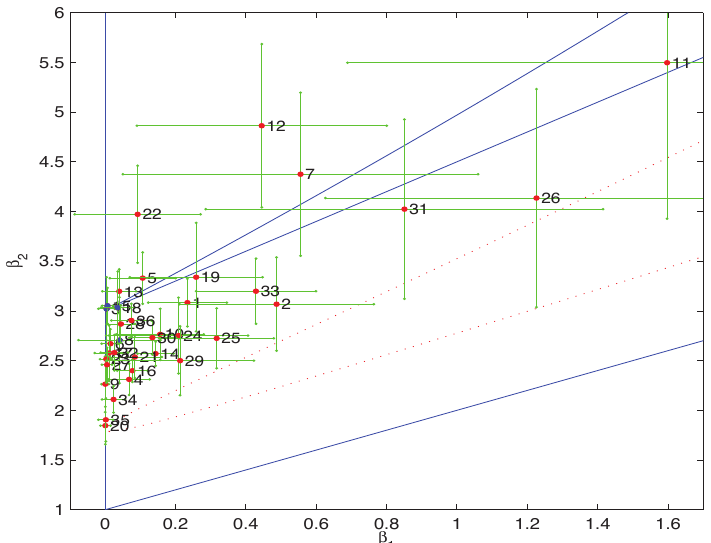
Fig. 2. Beta plane. From the 36 events: 28 belong to Pearson’s type I, 1 to type VI and 7 to type IV probability distribution. Error bars are calculated by the method of moments. Most of the events are close to normal distribution { ( β 1 , β 2 ) = (0 , 3) , but only for 4 events their error bars intersect the point of normal